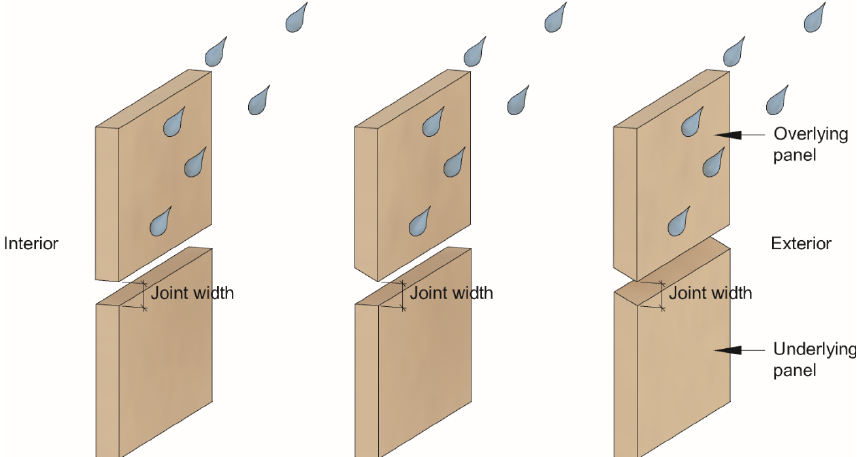
Figure 7. Different bevelled joint designs. From left: A rectangular joint, a top-bevelled joint, and a top-and-bottom bevelled